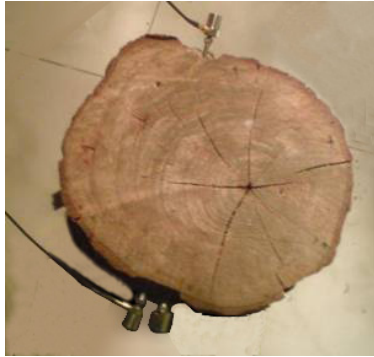
Figure 3. The Cinnamomum camphora sample used in the experiment.